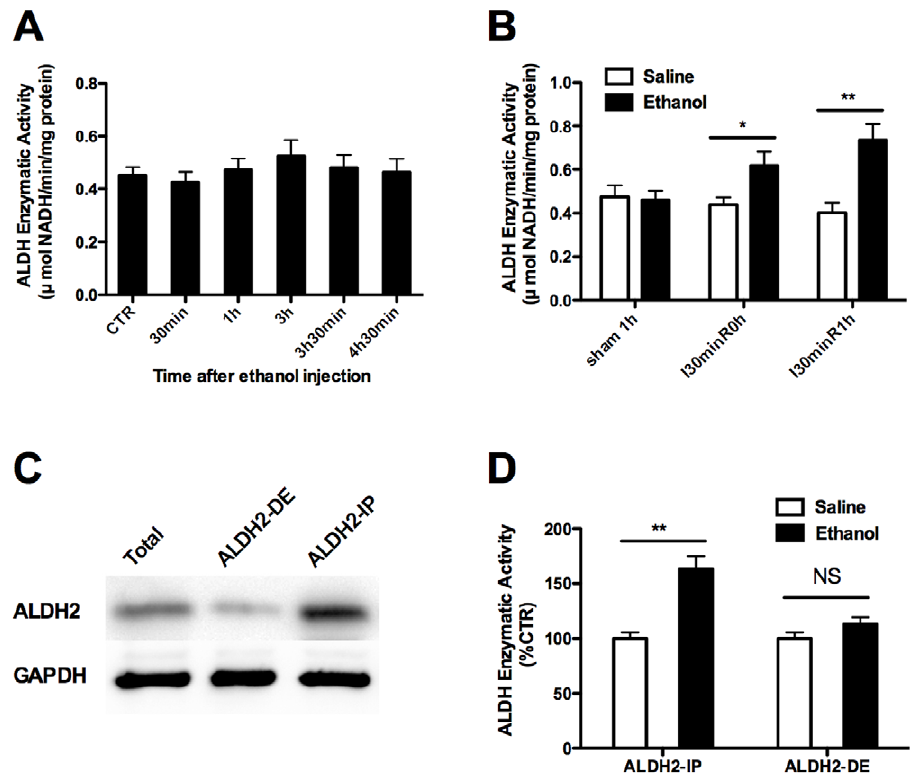
Figure 6. Ethanol pretreatment increased ALDH2 enzymatic activity after renal IR. A. Mice were pretreated with 1 g/kg ethanol and kidney samples were collected for ALDH enzymatic activity assay at different time after ethanol exposure. The CTR group did not receive any ethanol. B. Mice were pretreated with saline or 1 g/kg ethanol, and were exposed to a 30-min bilateral renal IR 3 h later. Kidney samples were collected at different time after reperfusion. C. Immunoprecipitation was performed to separate the total protein from kidney tissues to the ALDH2-enriched part (ALDH2-IP), and the ALDH2-depleted part (ALDH2-DE). D. ALDH enzymatic assay was performed in the ALDH2 enriched or depleted proteins. Results are mean values 6 SEM. ( n =4–5). (* p , 0.05, ** p , 0.01).